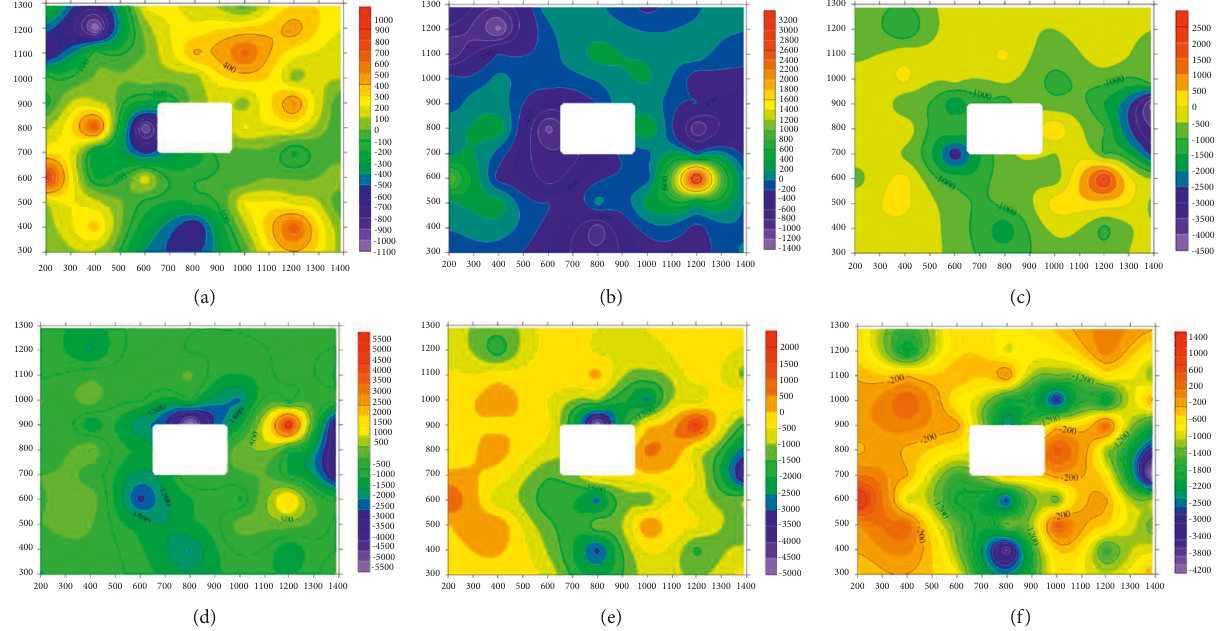
Figure 10: Evolution of horizontal strain field under different loads; (a) Under load level 4; (b) Under load level 14; and (c–e) Under load level 23 and cumulative duration is 541 mins, 542mins, 543mins and 544mins,